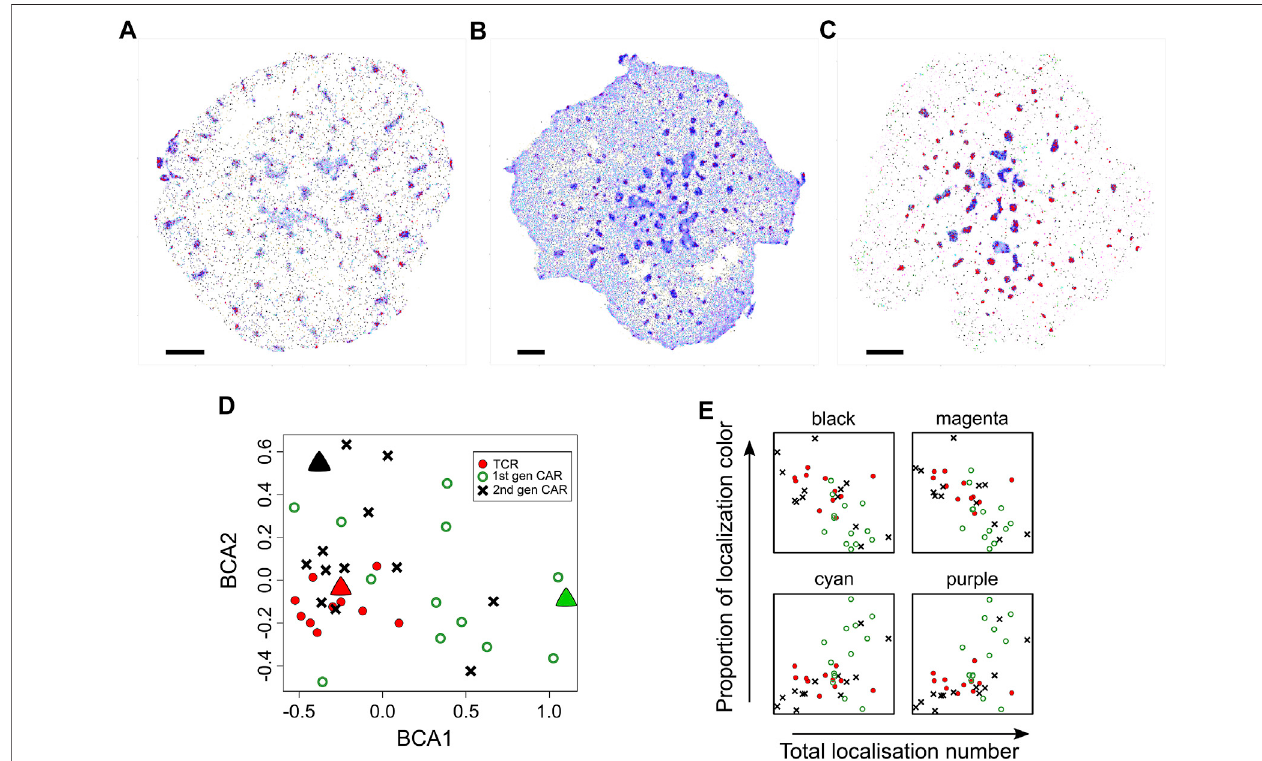
FIGURE 6 | Comparison of diversity in spatial organisation between cells expressing TCR, fi rst generation CAR or second generation CAR. (A – C) Representative SMLM images of CD3 ζ chain in the TCR-CD3 complex [ (A) , n (cid:1) 11 images], fi rst generation CAR [ (B) , n (cid:1) 13 images)] second generation CAR [ (C) , n (cid:1) 13 images] in Jurkatcells activated onpMHC-containingbilayers. Spatialorganisationsarecolour coded asin Figure 1 .Scale bars (cid:1) 2.5 μ m (D) Between-component analysis(BCA) ofthe9-dimensionalfrequencytablethatcontainstheoccupancyofeachspatialgroupaspercentagesoftotallocalisations.Eachsymbolrepresentsthetotalpoint pattern of TCR (red symbols), fi rst generation CAR (green symbols) and second generation CAR (black symbols) obtained from one SMLM image. Large triangles representtheSMLM images shownin (A – C) Adjacent datapointsindicate thattheirimageshaveasimilar overallspatialcompositioneventhougheachimage isunique. Thethreedatasetsaresigni fi cantlydifferentfromeachother(Methods)withtheTCRexhibitingtheleastcell-to-cellvariability. (E) Occupancyoftheblack,magenta,cyan and purple spatial organisations as a function of expression levels (total localisations) for TCR (red circles), fi rst generation CAR (green open circles) and second generation CAR (black crosses). Other spatial groups showed no correlation with expression